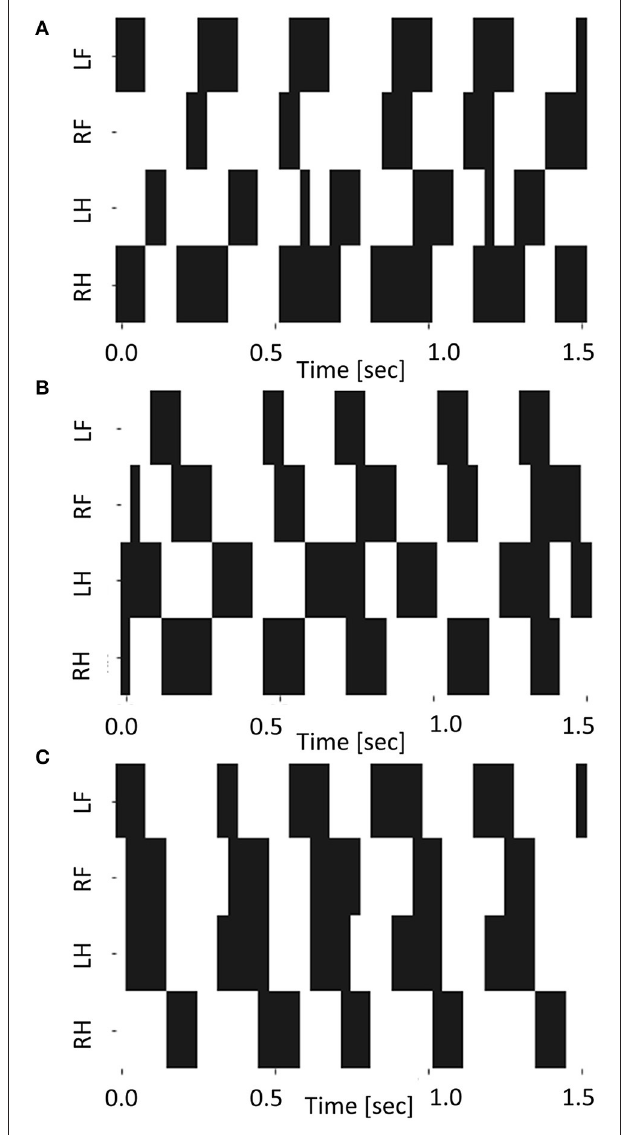
FIGURE 11 | The gait diagram during 0.0–1.5 s for (A) T φ = − 15, (B) T φ = 0, and (C) T φ =